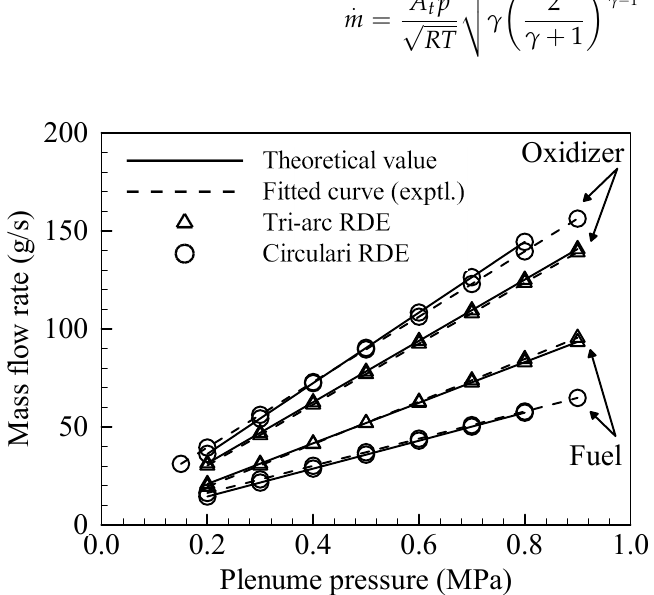
Figure 5. The mass flow rates of fuel and oxidizer in the tri-arc and circular RDEs.